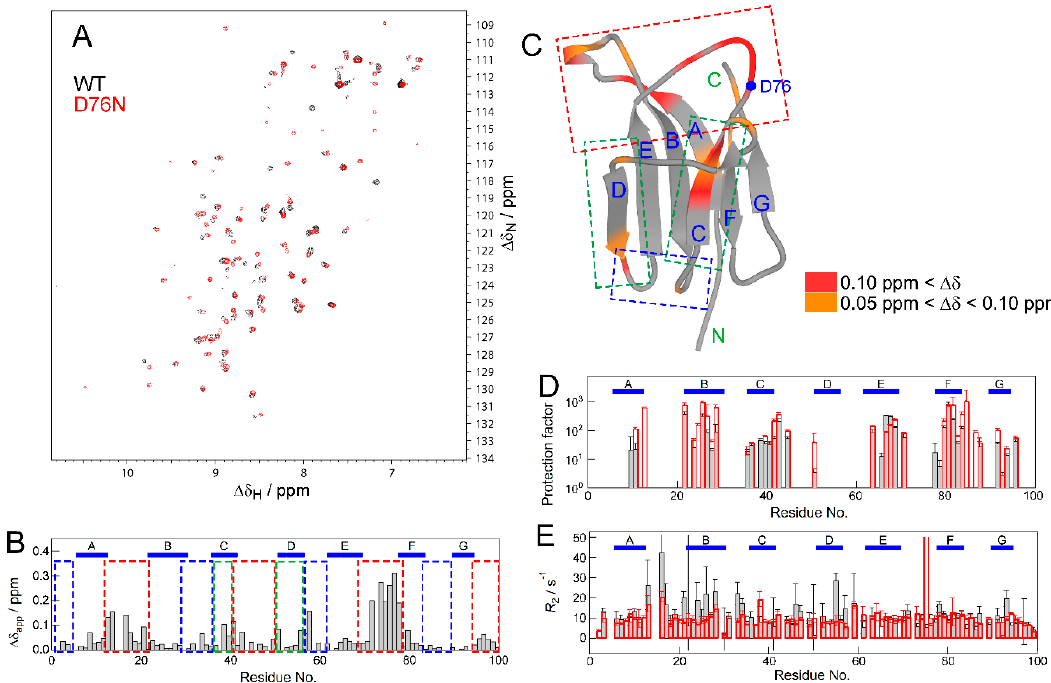
Figure 2. Comparison of NMR data of the wild type and D76N mutant. ( A ) An overlay of the 1 H– 15 N HSQC spectra of the wild type (WT) (black) and D76N (red) under ambient pressure conditions. ( B ) A plot of apparent chemical shift differences ( Δδ app ) against residue numbers. ( C ) The mapping of residues with significant Δδ values on the crystal structure. Colors indicate Δδ values as indicated by the color gauge below. In panels B and C, the red and blue boxes indicate N- and C-terminal loop regions, respectively. The green box indicates the position of the C- and D-strands. ( D ) Protection factors for each residue obtained from H/D exchange experiments. The position without a bar indicates the residue that was exchanged too fast to be measured even in the first measurement of the HSQC spectrum. ( E ) The plot of R 2 rates. Data indicated by gray and red bars in panels D and E are of WT and D76N, respectively.